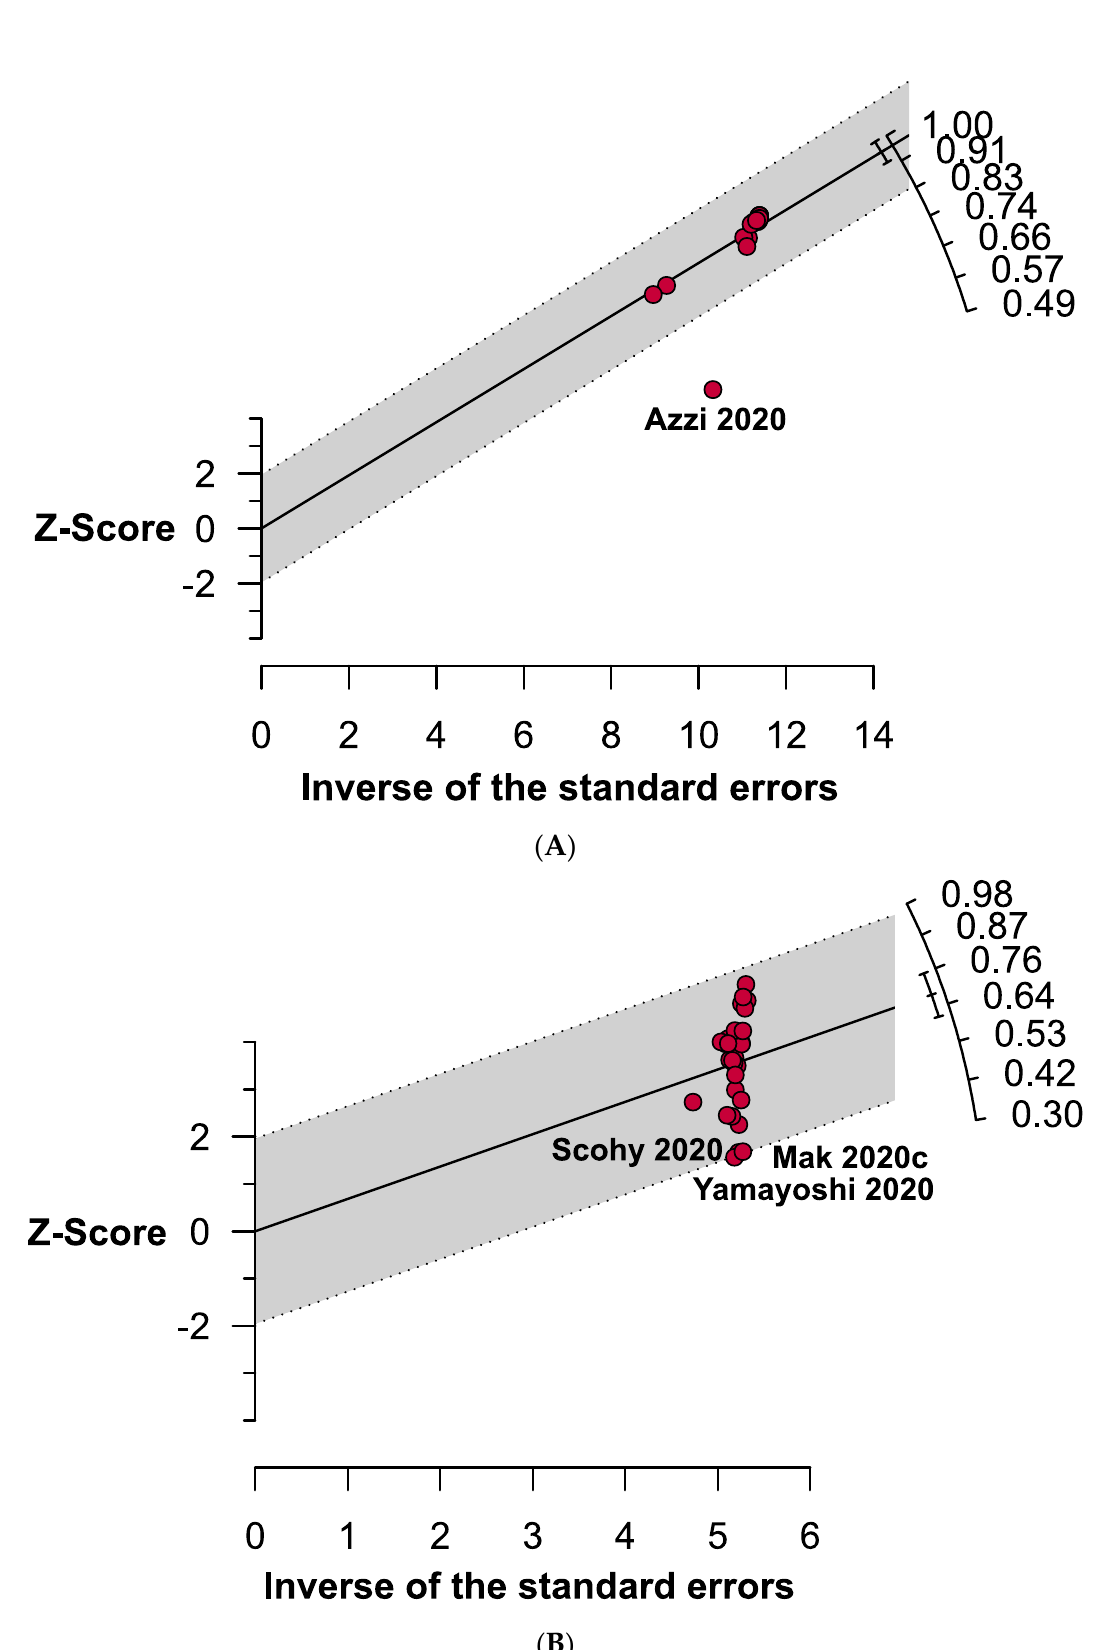
Figure 4. Galbraith plots representing outlier studies estimating ( A ) specificity and ( B ) sensitivity of rapid antigen tests in confirming COVID-19.